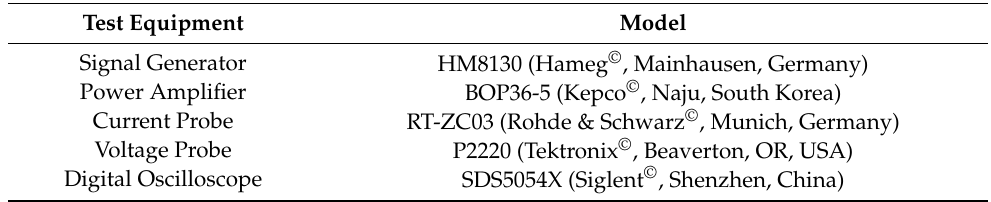
Table 4. Test equipment used for the magnetic property